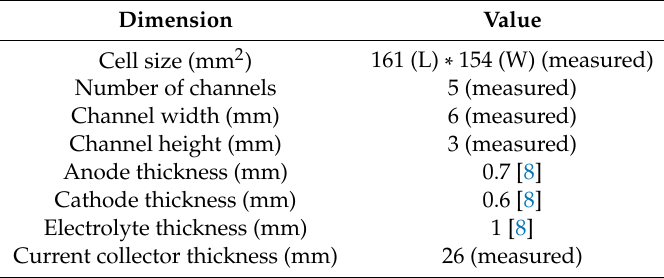
Table 1. Values for dimensions used in the MCFC